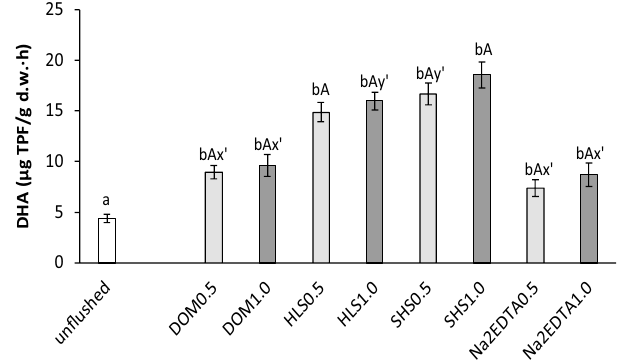
Figure 4. Changes in dehydrogenase activity (DHA) in soil before and after flushing with DOM, HLS, SHS and Na 2 EDTA. Small letters (ab) indicate statistically significant differences in DHA between the unflushed and flushed soils, capital letters (AB) indicate significant differences between the flow rates with one WA. The symbols x’ or y’ indicate no statistically significant differences between tested